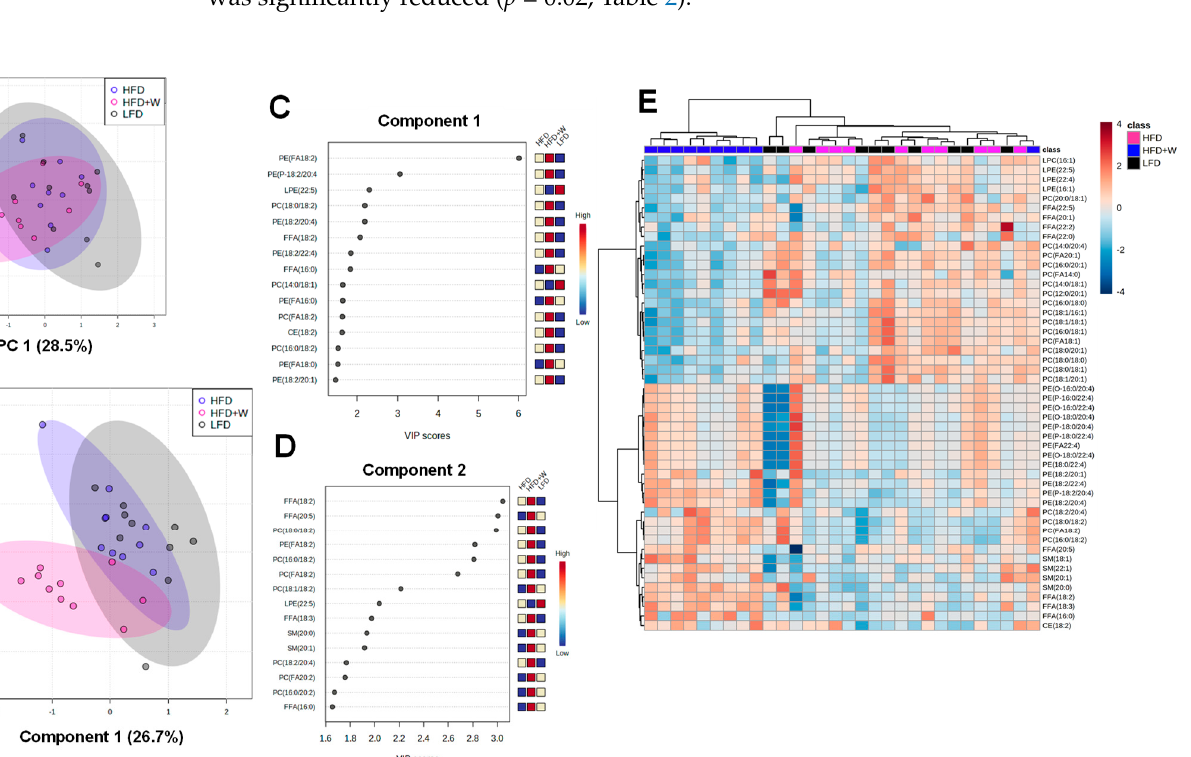
Table 2. Concentration of lipid classes in hippocampus.